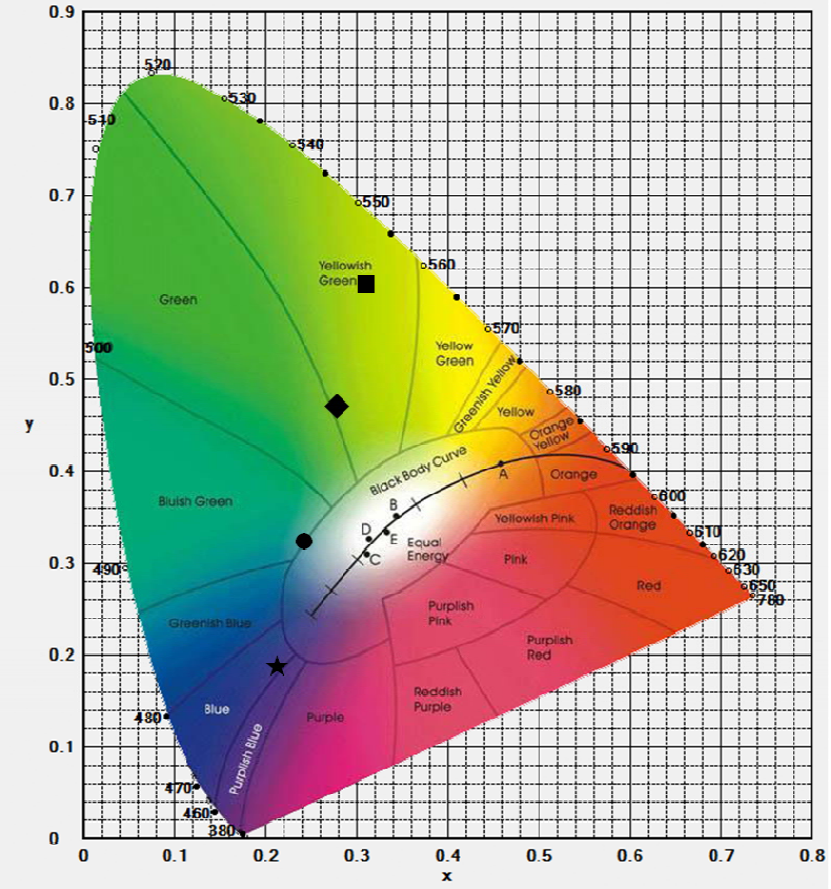
Figure 7. Chromaticity coordinates of the β -sialon:Eu 2+ deposits, with various mixed , prepared by the EPD process at 10 s depositing time.  ,  , amounts (0–1 g) of the SnO 2  , and  denote 0, 0.05, 0.1, and 1 g of the SnO addition, 2